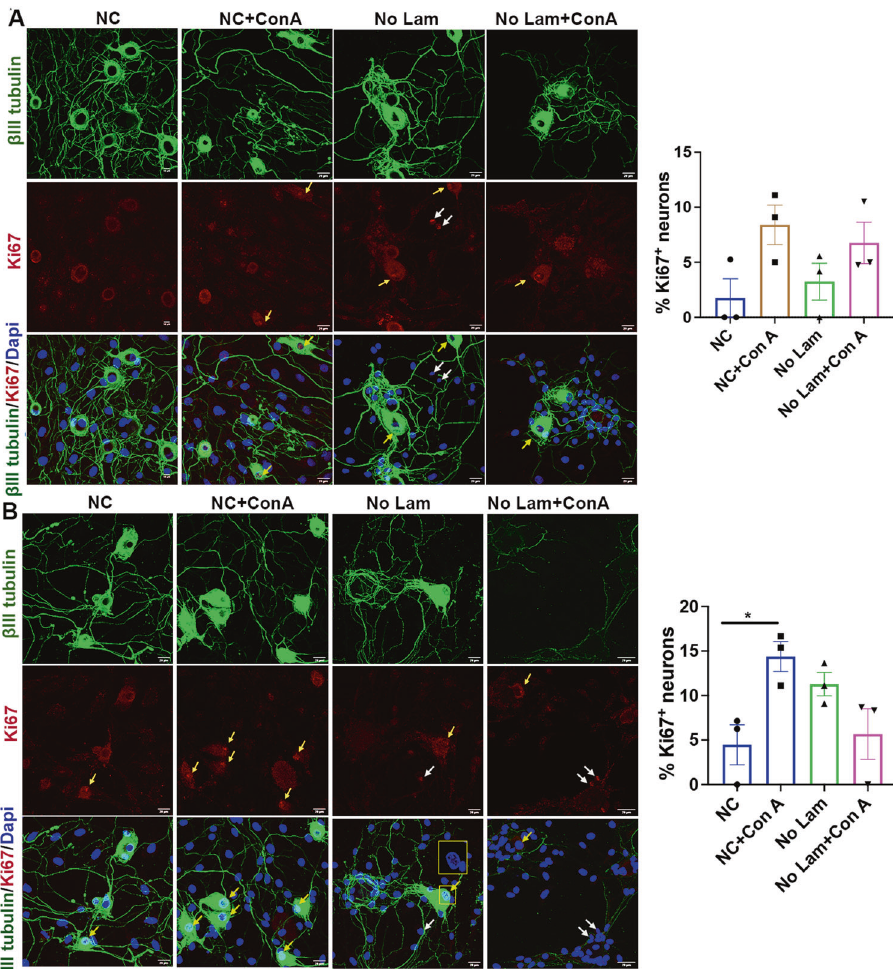
Fig. 1 Sensory neurons attempt cell cycle entry. Primary sensory neurons from adult rat DRGs show mild Ki67 expression (shown by yellow arrows) in 3-day A and 7-day B cultures at the indicated experimental conditions suggesting attempt for cell cycle entry. White arrows indicate Ki67 expression in satellite glial cells. Corresponding quanti fi cation is shown on the right panel. Results are expressed as percentage of neurons expressing Ki67. The total number of neurons were identi fi ed using β III tubulin staining [data presented as mean ± SEM; n = 3; * p ≤ 0.05; ANOVA (Tukey ’ s multiple comparisons